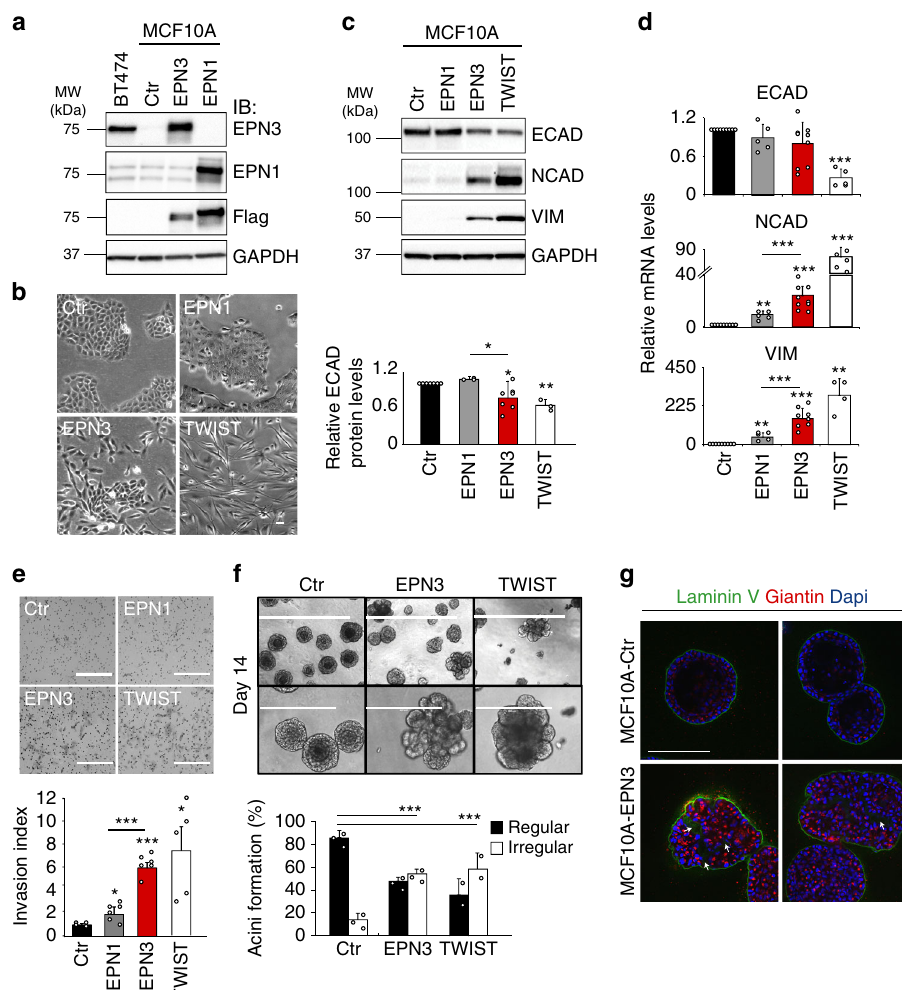
Fig. 2 EPN3 overexpression induces EMT in MCF10A cells. a MCF10A cells expressing Flag-EPN3 (EPN3) or Flag-EPN1 (EPN1) or empty vector (Ctr), and IB with the indicated Ab. GAPDH, loading control. BT474 cells: positive control for EPN3 overexpression. Left, MW markers. b Phase-contrast microscopy of MCF10A cells as in ( a ), compared with MCF10A-TWIST. Bar, 50 μ m. c , d Expression of EMT markers, in the indicated cell lines, by IB ( c ) or RT-qPCR ( d ). In ( c , top), GAPDH, loading control. Left, MW markers. In ( c , bottom), quanti fi cation of ECAD protein levels, normalized on GAPDH expression, is reported as relative fold change compared with Ctr cells. Results are the mean ± S.D. ( n ≥ 3). P values (Each Pair Student ’ s t test, two-tailed) are vs. Ctr, unless differently indicated; *, <0.05; **, <0.01; ***, <0.001; ns, not signi fi cant (here and in all other fi gures). In ( d ), the data were normalized on the average expression of the housekeeping genes 18S-ACTB-GAPDH , and reported as relative fold change compared with Ctr cells (mean ± S.D., n ≥ 4); unless otherwise indicated, the same normalization procedure was used in all fi gures. e Matrigel invasion assay of the indicated cells (24 h). Top, representative images (Bar, 400 μ m); bottom, invasion index (mean number of invading cells/ fi eld over the control) ± S.D. (at least four fi elds of view were counted/ sample, each in two independent experiments). P value, Student ’ s t test two-tailed. f Morphogenetic Matrigel assay. Top, representative bright- fi eld